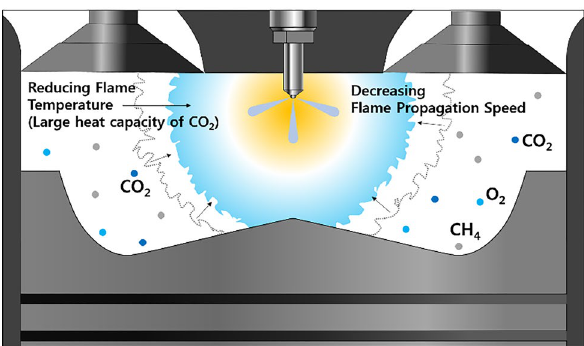
Figure 19. Schematic of the effects of CO 2 on MPDF combustion.